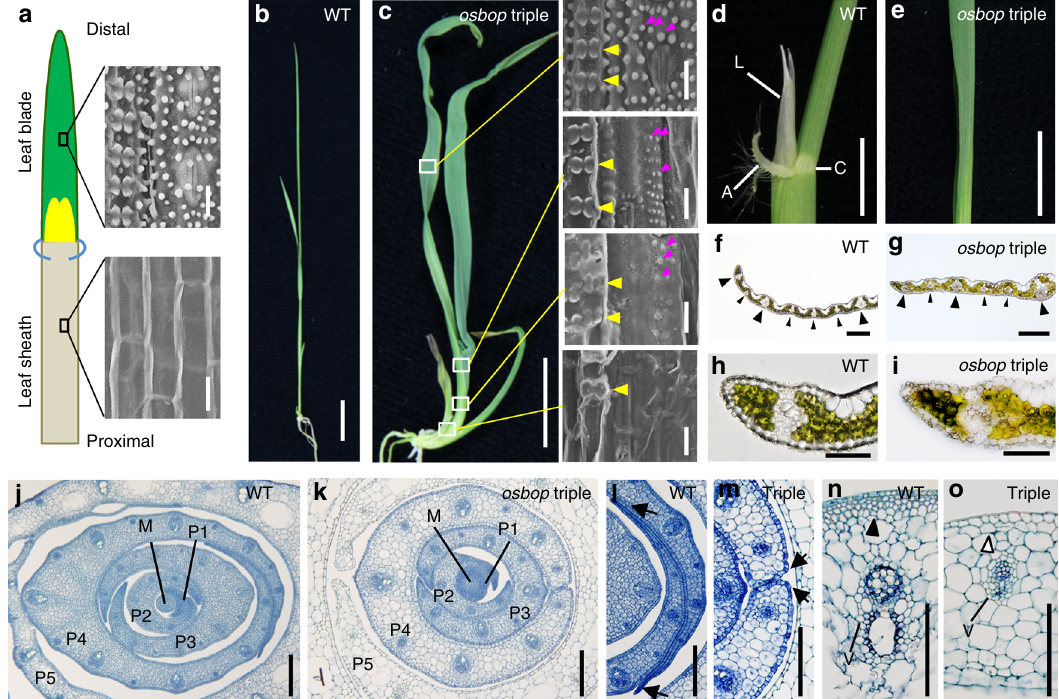
Fig. 1 Morphology of osbop triple mutants. a Structure of a rice leaf. A leaf sheath (gray) and a leaf blade (green) develop at the proximal and the distal position, respectively. Ligules (yellow) and auricles (light blue) form in the junction between the sheath and the blade. SEM views of the adaxial surface of the sheath (lower) and the blade (upper) are shown. b A WT seedling. c An osbop1-1 osbop2-1 osbop3-1 triple mutant seedling. SEM views of the adaxial surface of the third leaf in the triple mutant are shown to the right of the panel (Bars idicate 20 μ m). White squares indicate the position of the SEM views. Yellow and magenta arrowheads, respectively, indicate dumbbell-shaped cells and protuberances, both of which are absent in the adaxial surface of the leaf sheath, but present in that of the leaf blade. d Boundary region between the leaf blade and the leaf sheath in the WT. L, ligule; A, auricle; C, collar. e Middle region of a leaf in the triple mutant lacking all organs formed at the leaf blade/sheath boundary in the WT. f , g Cross-sections of leaf blade in the WT ( f ) and the triple mutant ( g ). Large and small arrowheads indicate large and small vascular bundles, respectively. h , i Cross-sections of leaf blade margins in the WT ( h ) and the triple mutant ( i ). j , k Cross-sections of a shoot lower region of the WT ( j ) and the triple mutant ( k ) when the sixth leaf has emerged. M, shoot apical meristem. l , m Close-up views of the marginal region of the WT ( l ) and the triple mutant ( m ). Arrows indicate leaf margins. n , o Close-up views of the large vasculature (V) in the lower leaf region of the WT ( n ) and the triple mutant ( o ). An arrowhead in n and an open arrowhead in ( o ) indicate abaxial sub-epidermal cells in the WT and the triple mutant, respectively. Bars: 20 μ m ( a ), 1 cm ( b , c ), 500 μ m ( d , e ), 200 μ m ( f , g ), 100 μ m ( h – o (Fig. 1k, m). In the leaf of the WT plants, the vasculature is